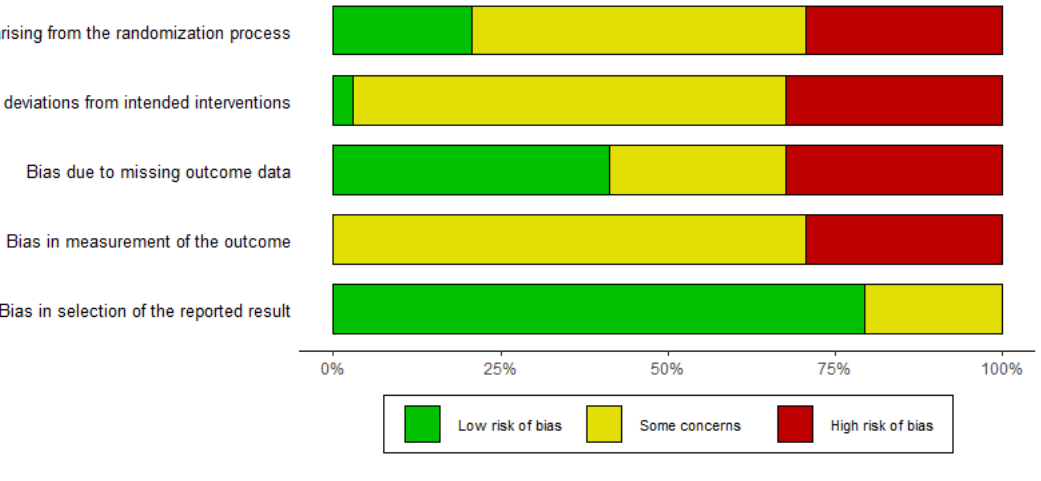
Table 1. Results from publication bias funnel plot and trim and fill analysis . Parameter—Odds Ratio [95% CI]